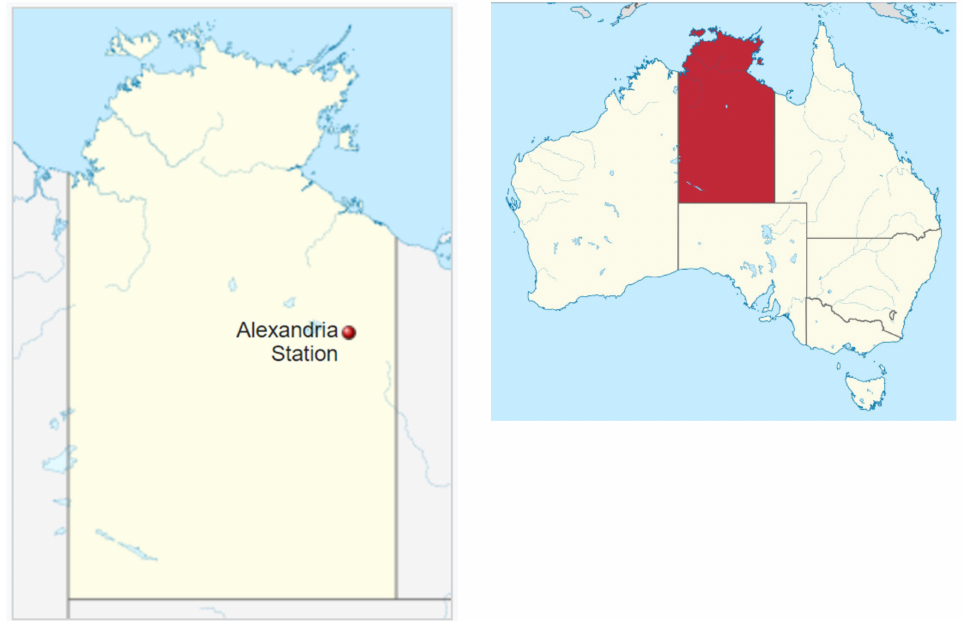
Figure 9. Location of Alexandria Station in the Northern Territory and location of the Northern Territory (shaded red inset) within Australia [22].